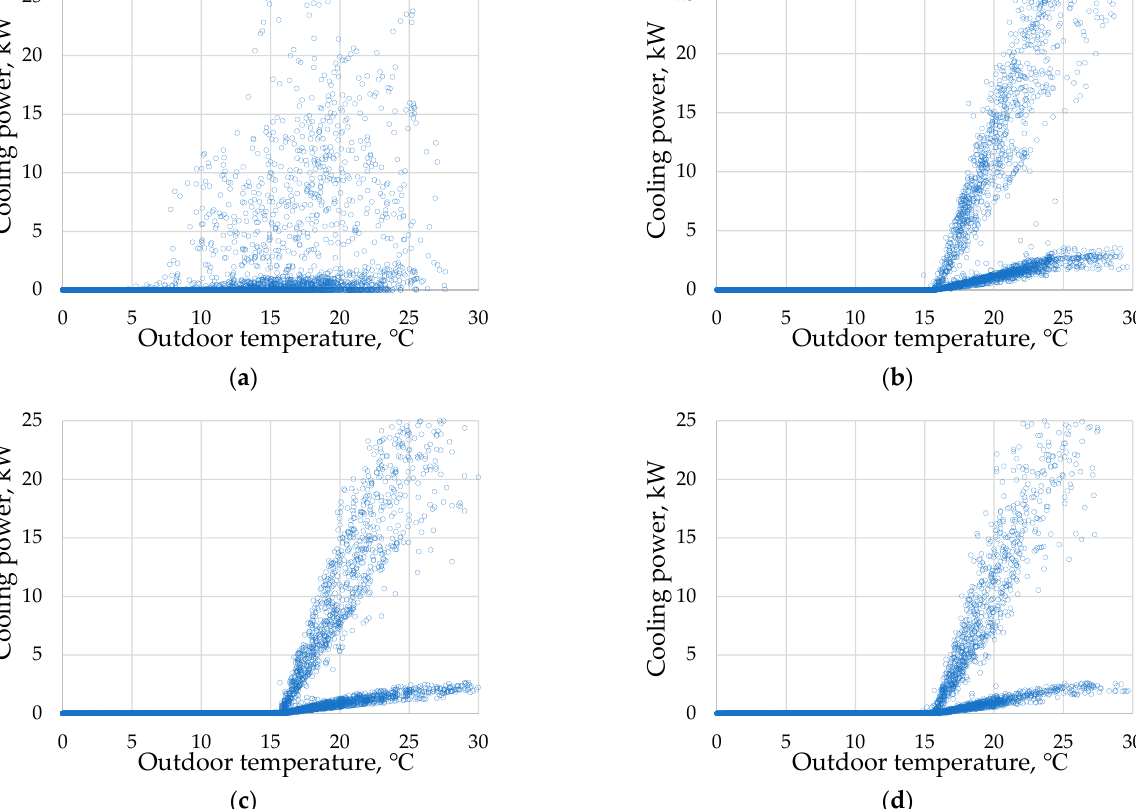
Figure 5. Base temperature of cooling degree day (CDD) for different climates ( a ) Tallinn, ( b ) Sapporo, ( c ) Paris, and ( d ) Brussels.